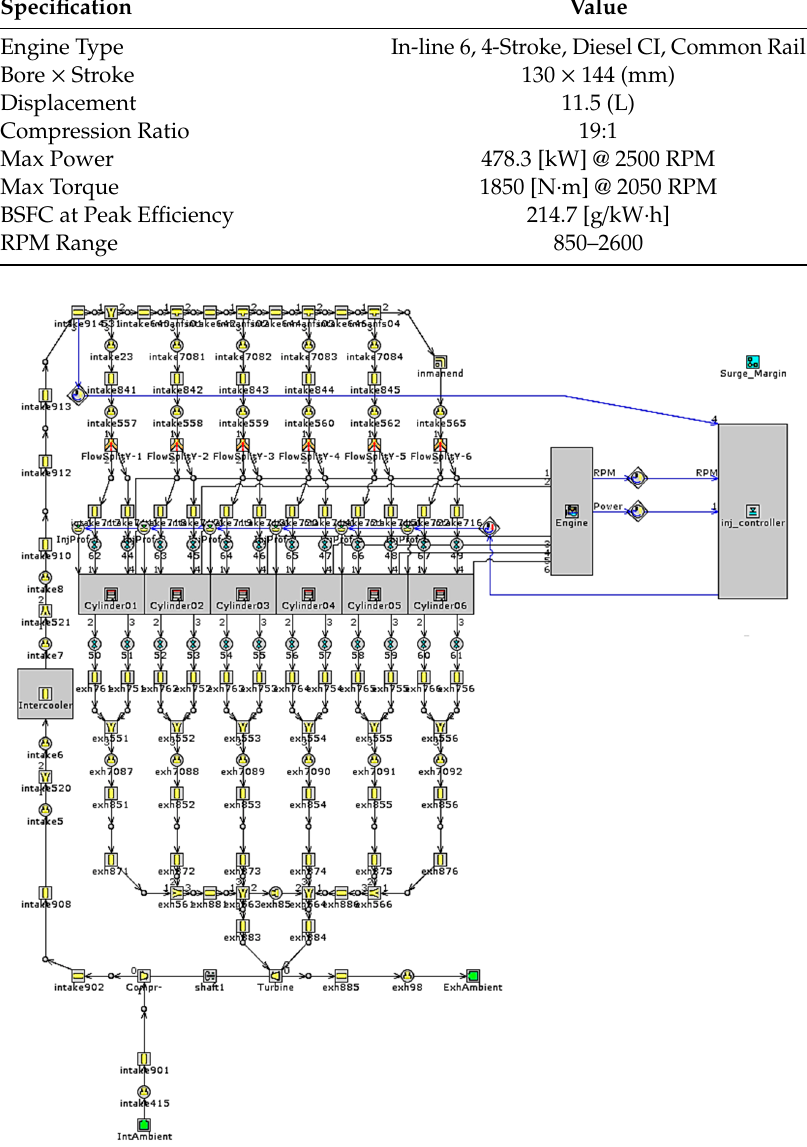
Figure 3. Engine model in GT-Power software.